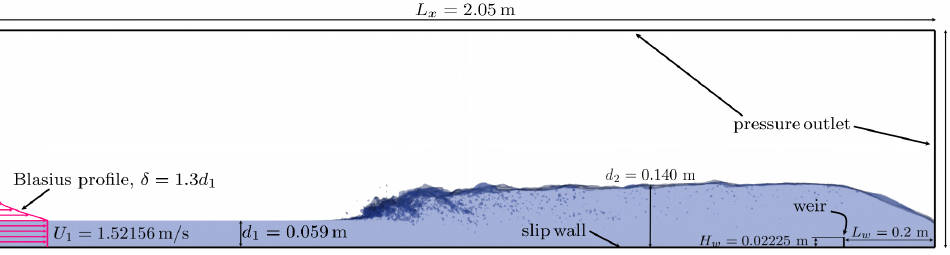
Figure 2. Simulation setup. Table 1. Simulation